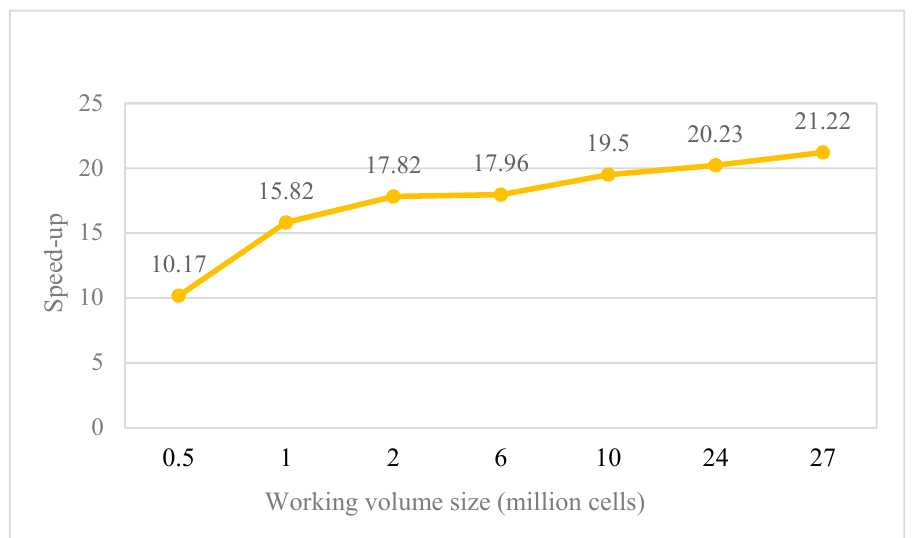
Figure 11. Gain in GPU runtime with respect to CPU for various numbers of nodes.